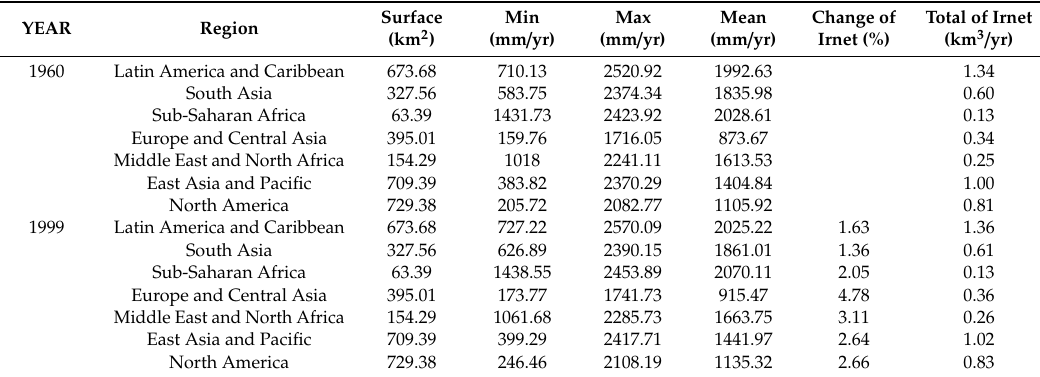
Table 1. Historical regional net irrigation water requirement.